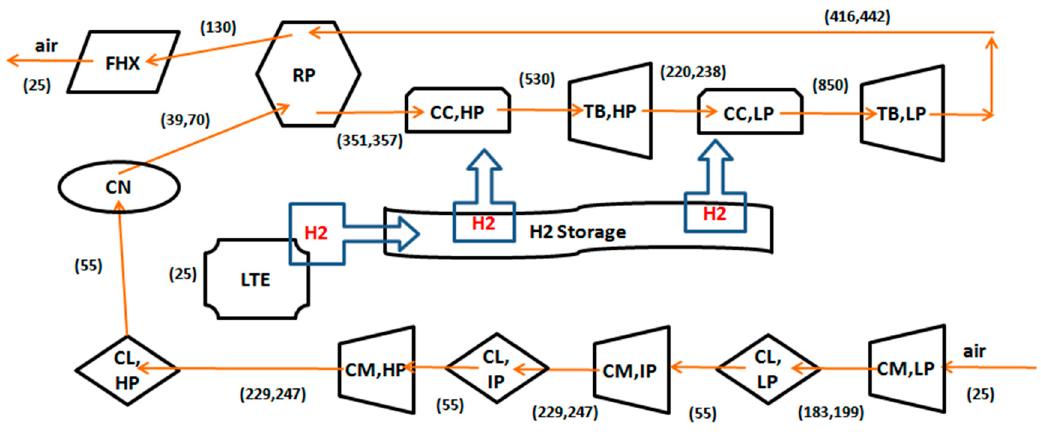
Figure A4. Temperature range of the CAES-LTE system in the base case scenario. Values in each bracket show minimum and maximum temperature. The cavern operates in 5–7 MPa range. The different stages of the compression and expansion trains have equal pressure ratios.